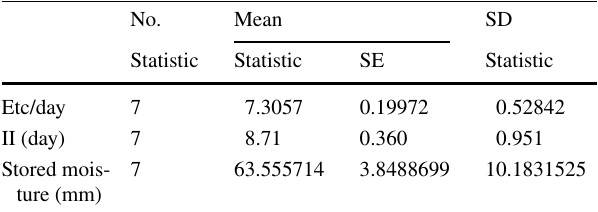
Table 5 Statistical analysis of determined irrigation interval